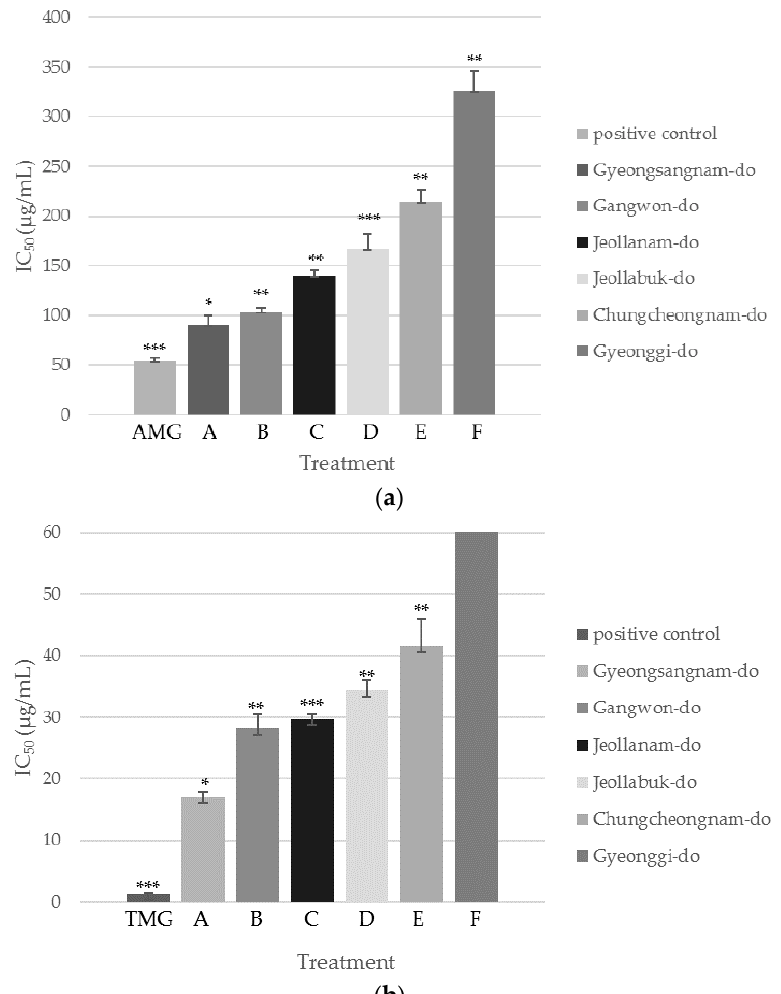
Figure 1. ( a ) IC 50 values of SCS extracts from different provinces of Korea in AGEs assay; ( b ) IC 50 values of SCS extracts from different provinces of Korea in AR assay. Values are presented as mean ± SD ( n = 3). * p < 0.05 compared with the positive control group; ** p < 0.01 compared with the positive control group; *** p < 0.001 compared with the positive control group (Student’s t test).